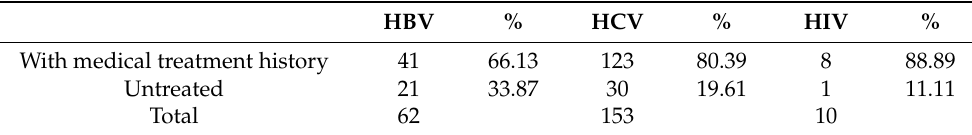
Table 3. New detection rate for infectious-disease-positive